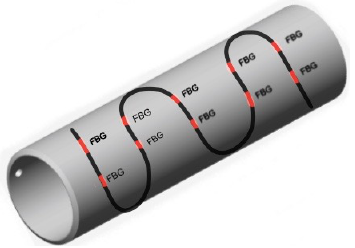
Figure 3. Schematic of the experimental support under construc- tion for Multiple FBGs in a cylindrical